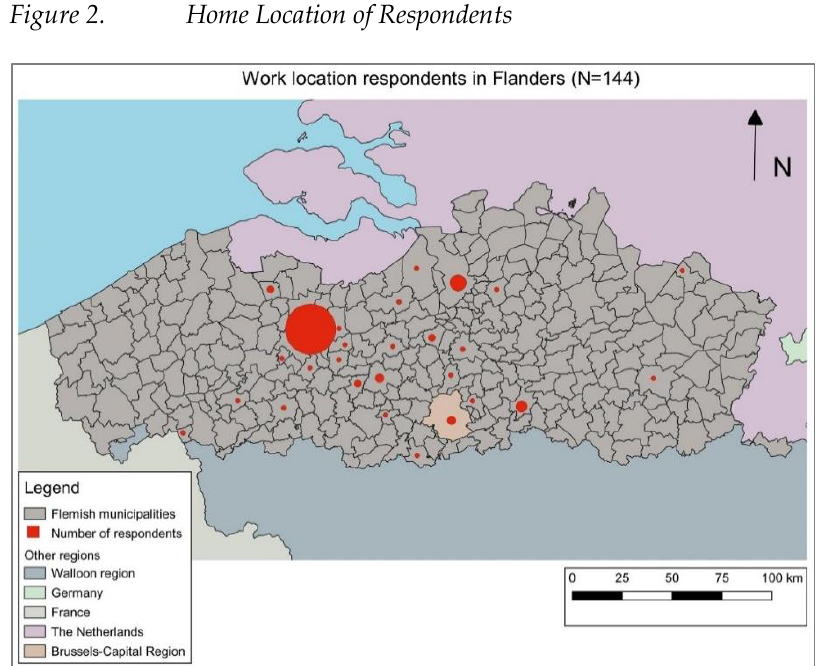
Figure 3. Work Location of